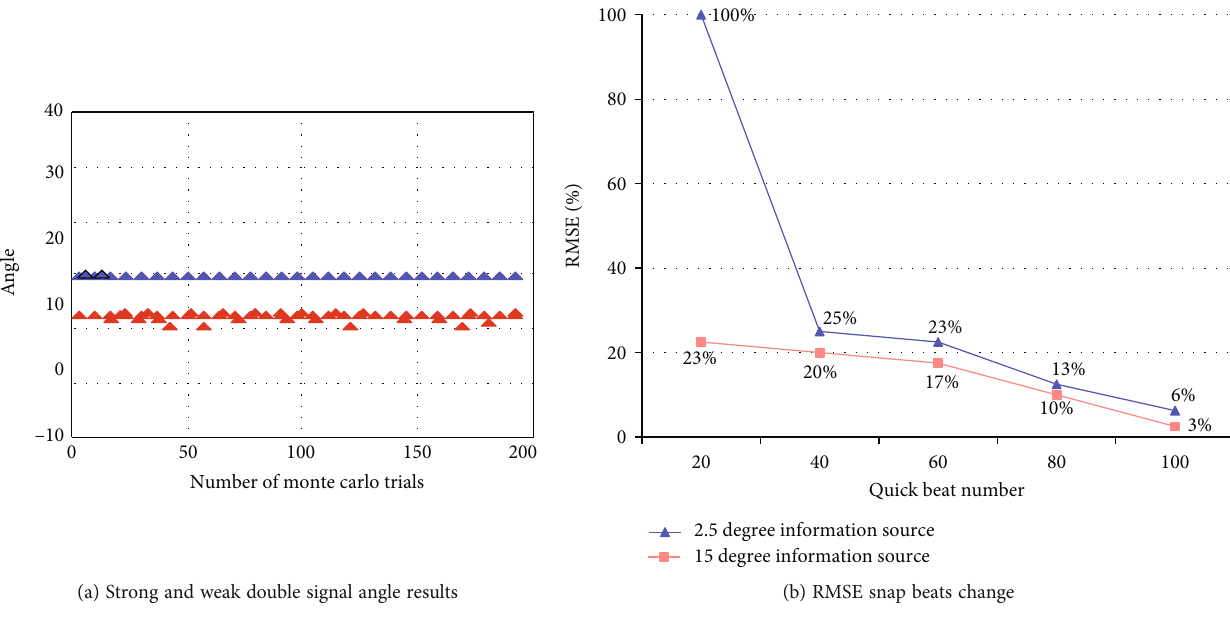
Figure 8: RMSE results DOA of strong and weak IoT music signals of T-matrix fast reconstruction algorithm.